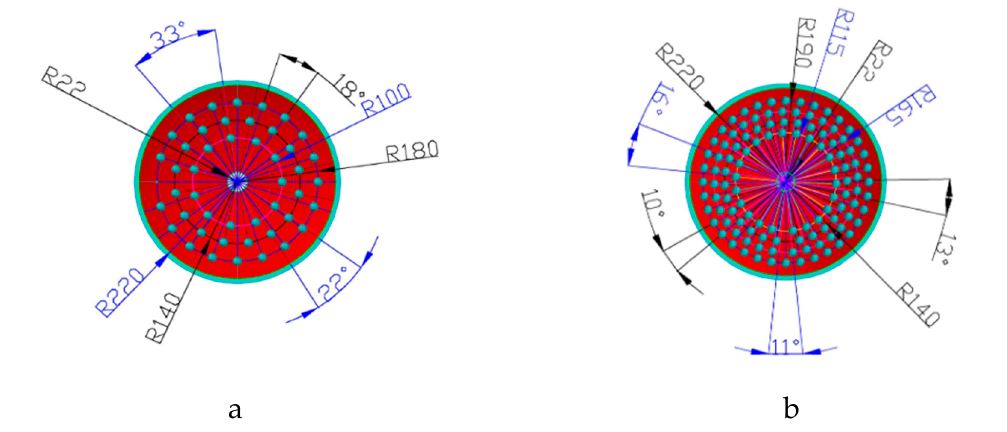
Figure 2. Arrangement of non-smooth units at 10% unit density ( a ) and at 30% unit density ( b ). Solid element with 8 nodes, 185 element type and Drucker–Prager model was used for element formulation and soil meshing as shown in Figure 3. For the harrowing disc, solid element with 10 nodes (45 element type) and elastic isotropic material model was used. The analysis was then conducted by adopting the surface–surface contacting (TARG 170 and CONTA 174). The solution criterion was selected as large displacement